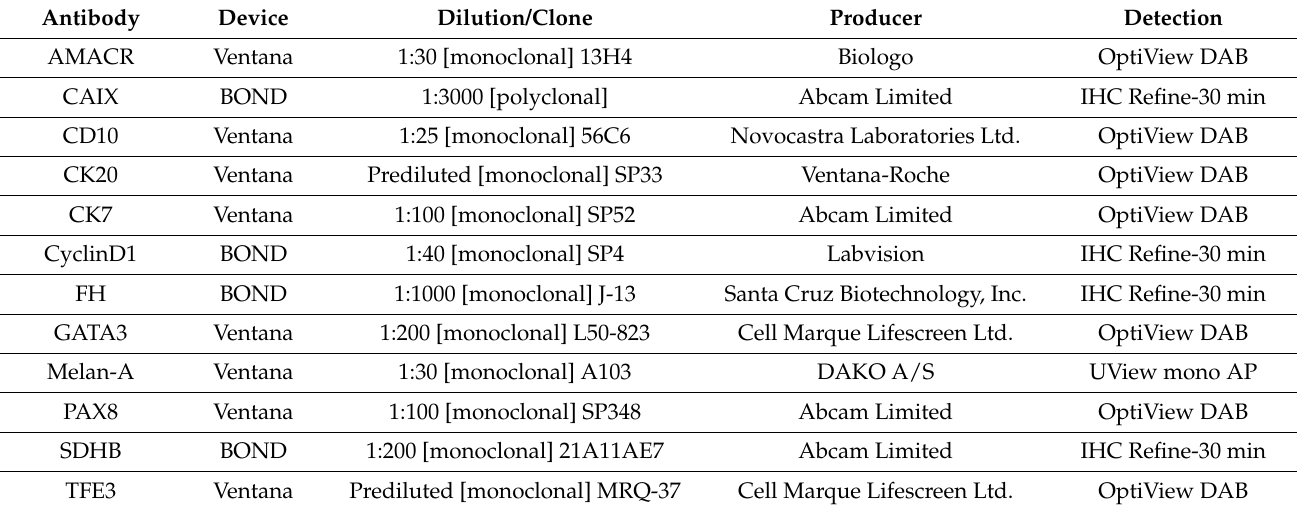
Table 1. Details about immunohistochemistry